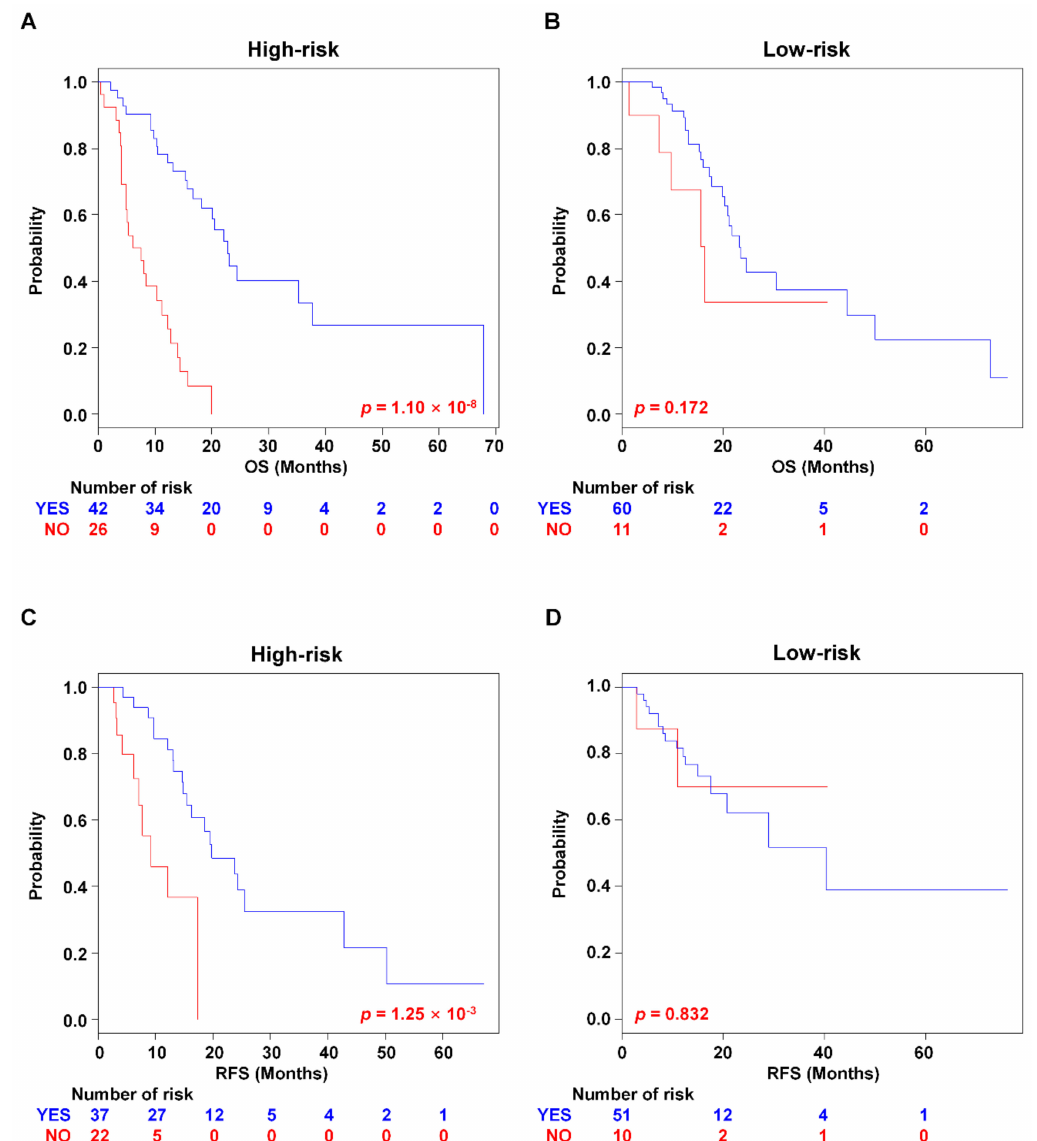
Figure 7. Kaplan–Meier survival analysis of PAC patients with targeted molecular therapy. The patients were separated into risk-subgroups according to targeted molecular therapy. Kaplan–Meir analyses wereused to evaluate the therapeutic advantage. ( A , B ) Kaplan–Meier plots forOS of two risk-subgroups. ( C , D ) Kaplan–Meier plots for RFS of two risk-subgroups. p -Values were computed by the log-rank